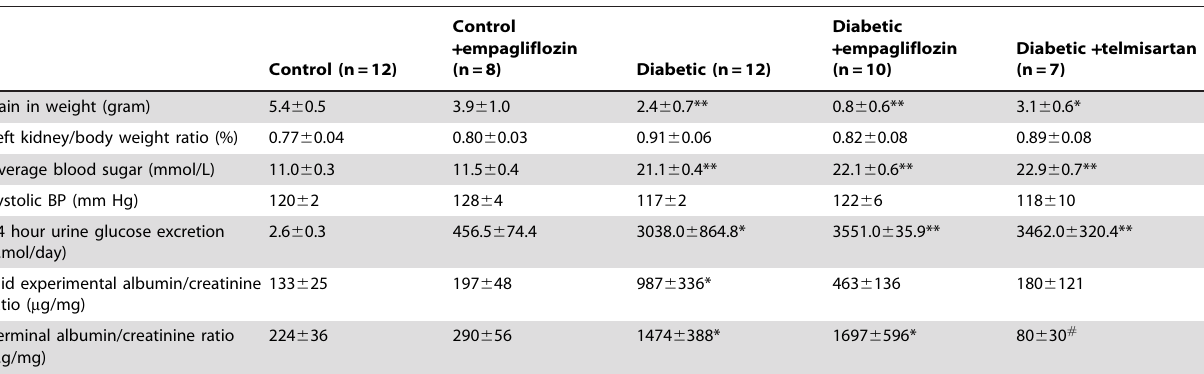
Table 1. Physical and clinical